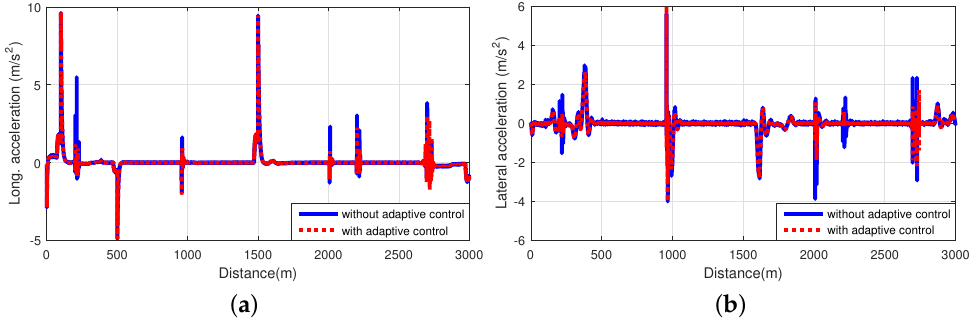
Figure 14. ( a ) Longitudinal acceleration. ( b ) Lateral acceleration.